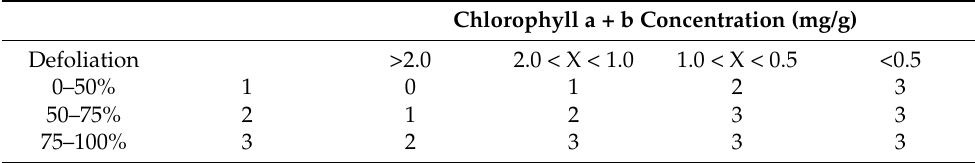
Table 3. Severity classes score of individual trees as a function of defoliation percentage and pigment concentration (total Chlorophyll). Severity classes 0: non-damage 1: slight, 2: medium, and 3: High. Adapted from Lakatos et al.